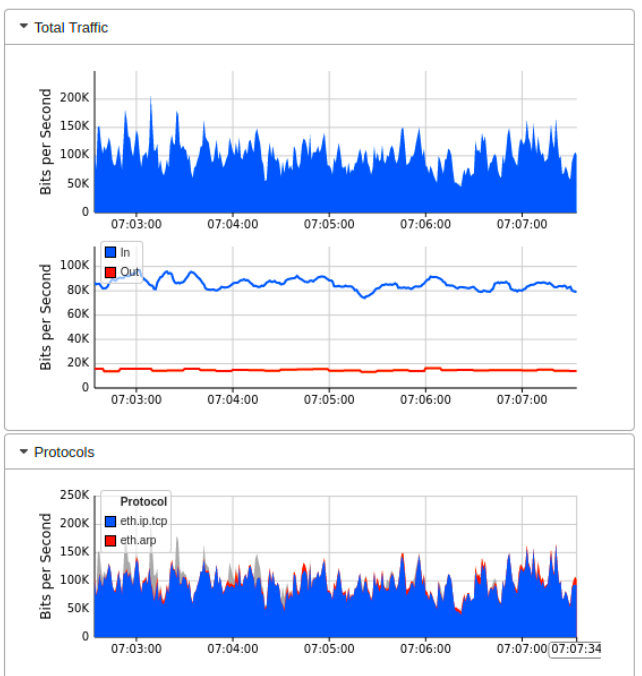
Figure 14. Network bandwidth dashboard during real-time normal traffic